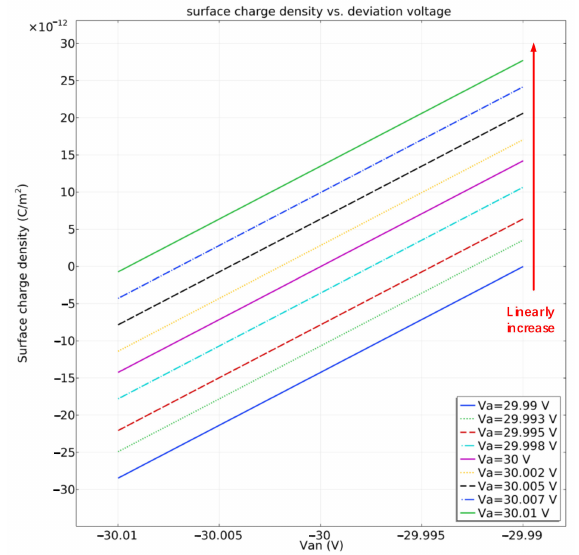
Figure 12. Variation of surface charge density of neutral region with fluctuating applied voltage.